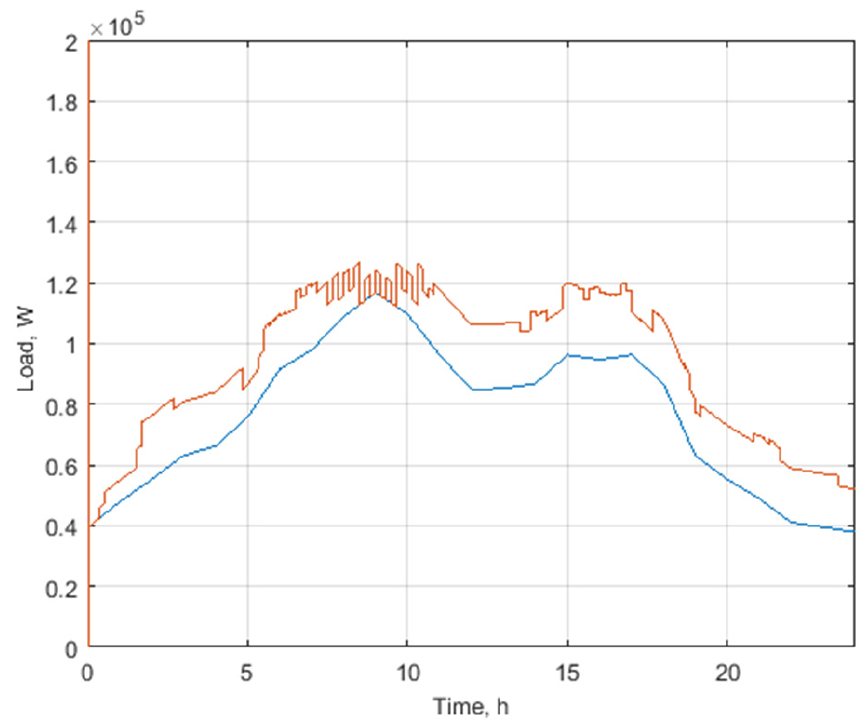
Figure 13. Power consumption over twenty-four hours based on a controlled charge. (Brown— general demand; blue—CLN load).